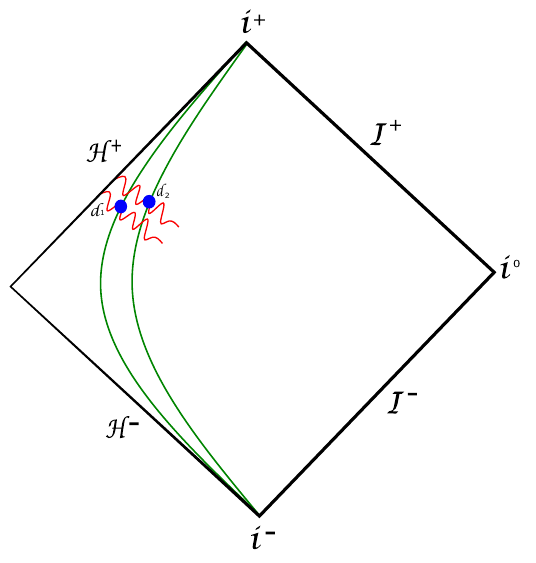
Figure 1 . A schematic diagram of the displacement memory e(cid:11)ect near the horizon of a black hole. The pulses of gravitational radiation pass the detectors and generate a permanent change in the relative